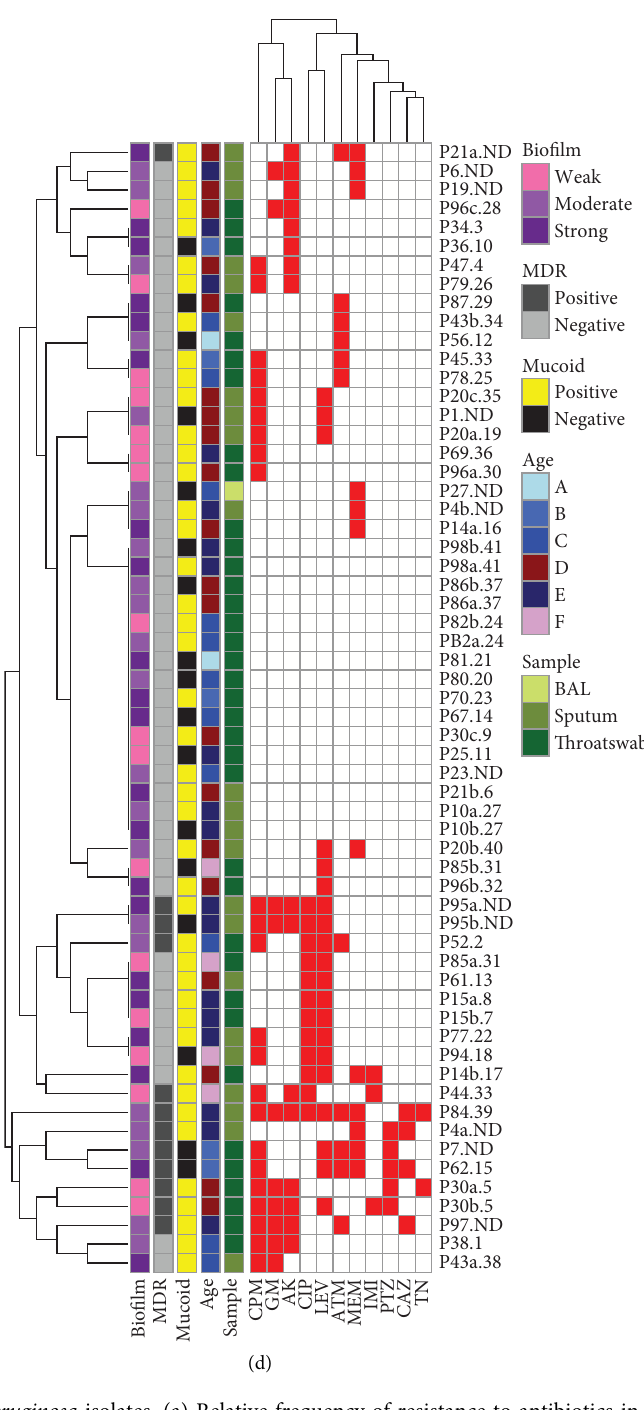
Figure 3: Population structure of P. aeruginosa isolates. (a) Relative frequency of resistance to antibiotics in P. aeruginosa isolates and bioflm formation status. (b) Relative frequency of MDR and non-MDR P. aeruginosa isolates vs. age group. (c) Relative frequency of mucoid/non mucoid phenotype of P. aeruginosa and bioflm formation status. (d) Overview of antimicrobial-resistance profles and other characteristics of P. aeruginosa isolates. GM, gentamicin; CIP, ciprofoxacin; IMI, imipenem; CAZ, ceftazidime; MEM, meropenem; PTZ, piperacillin-tazobactam; CPM, cefepime; ATM, aztreonam; TN, tobramycin; AK, amikacin; LEV, levofoxacin; age group is represented as A < 2, B 2–5, C 6–10, D 11–15, E 16–20, F 20–30 years of age; (P) P. aeruginosa ; a, b and c letters represent the diferent morphotypes of the same bacteria isolated from the same patient; red squares are representative of resistance and white squares represent susceptibility to the tested